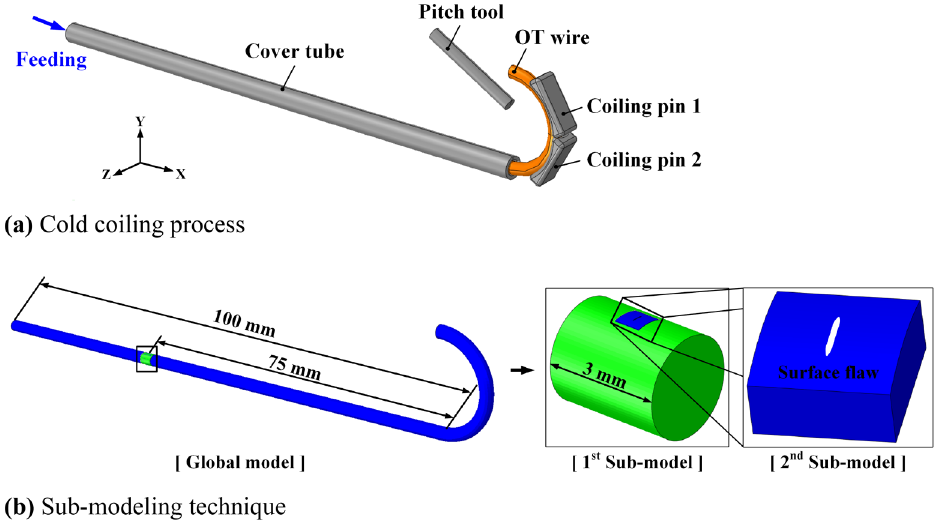
Figure 11. FE model of forming process for engine valve spring.